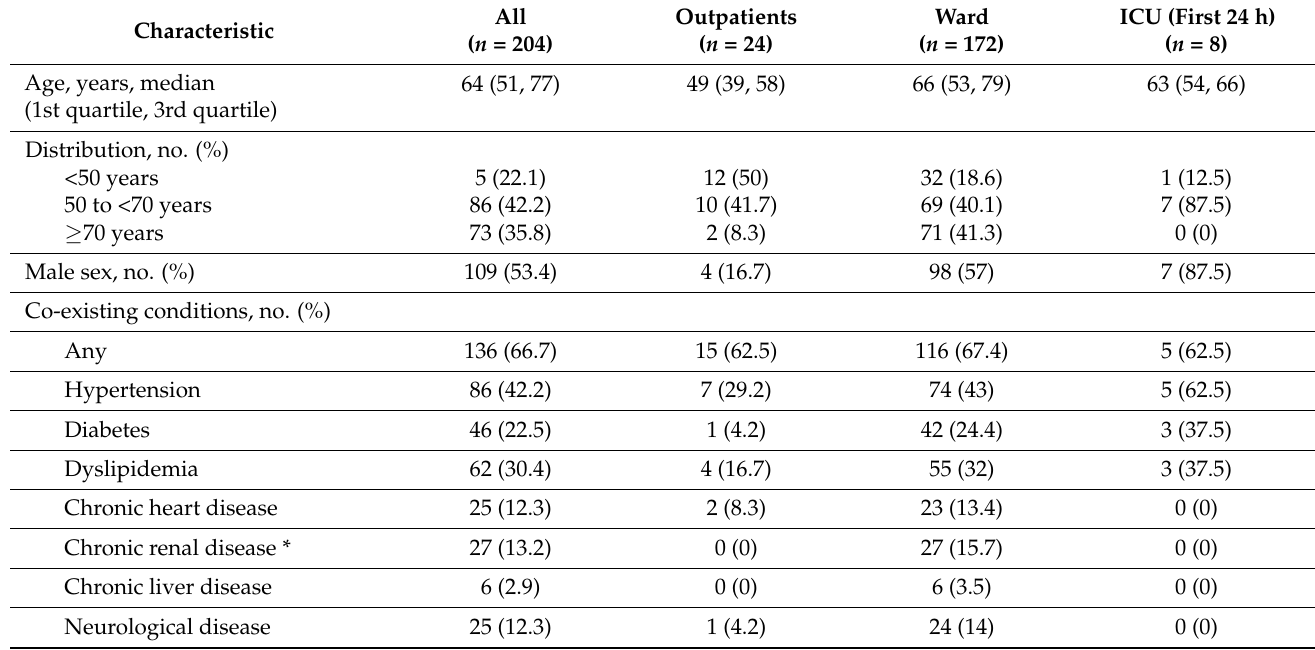
Table 1. Patient Characteristics Related to Baseline, Severity, Treatment Received, Analytical Parame- ters, Level of Respiratory Support and